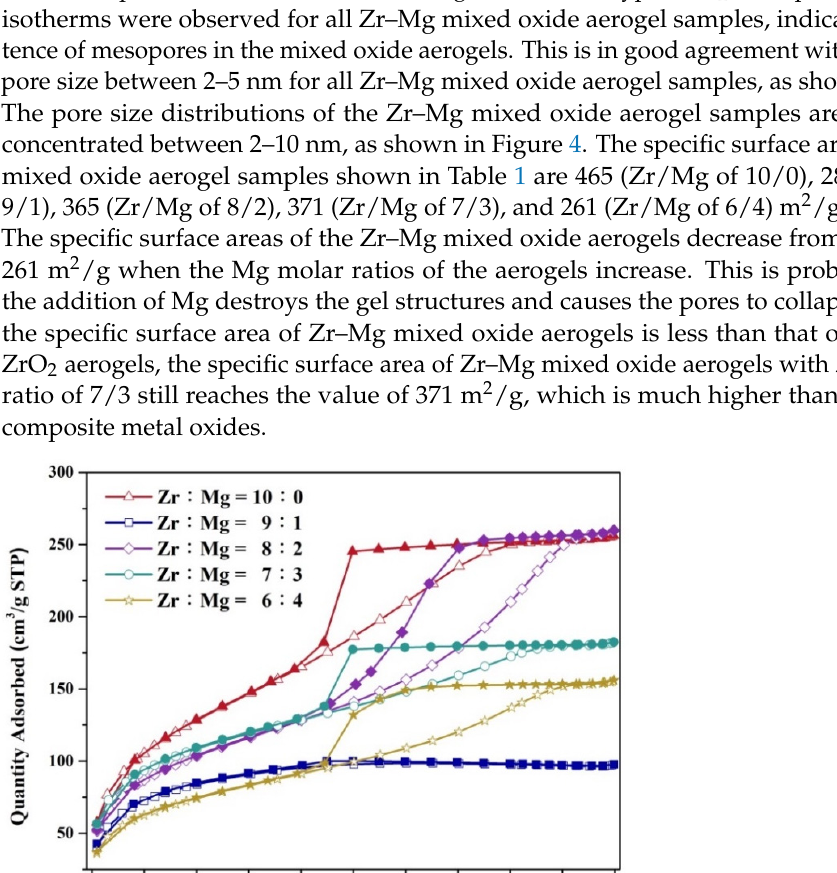
Figure 2. The EDS elemental mapping of ( a ) Zr, ( b ) Mg, and ( c ) O distribution of the Zr–Mg mixed oxide aerogels with Zr/Mg molar ratio of 7/3.